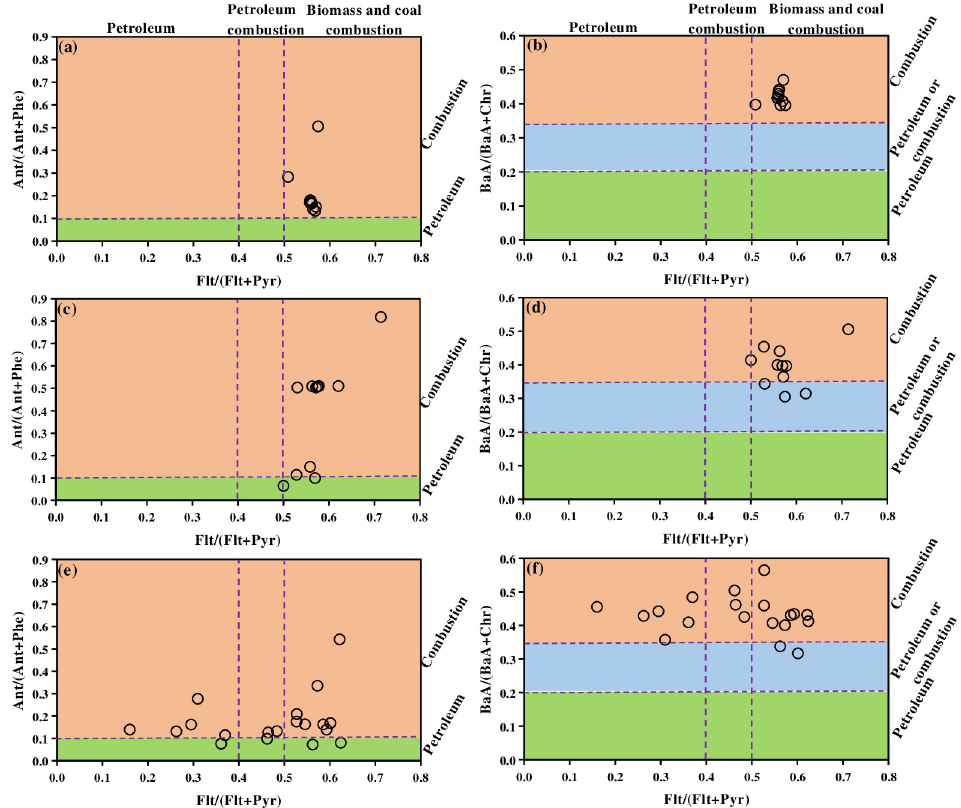
Fig 1. Cross plots for PAH isomeric ratios in surface soils in urban (a, b), suburban (c, d) and rural area (e, f). The calculations of source ratios followed the methods described by Yunker et al [15].